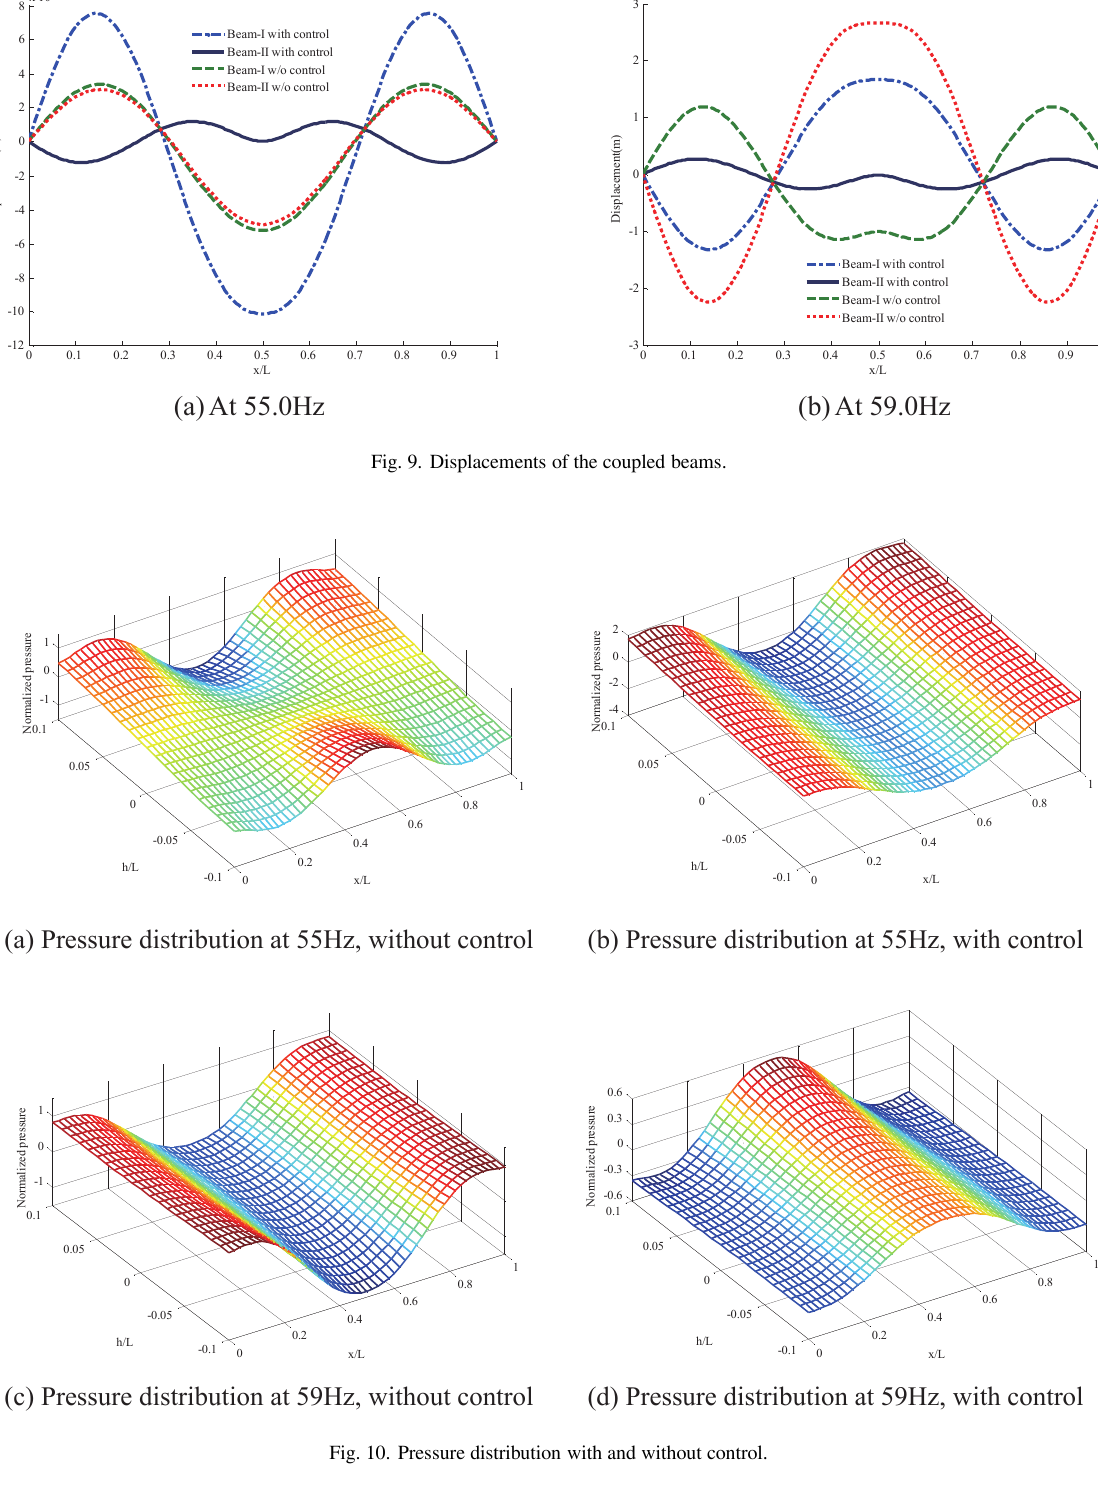
Fig. 10. Pressure distribution with and without